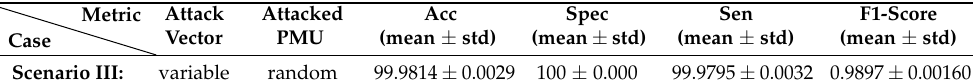
Table 5. The mean and standard deviation of the PLV performance for the IEEE-30 bus system.